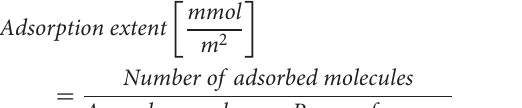
The error bars represent the standard deviation from the mean value of simulations performed in